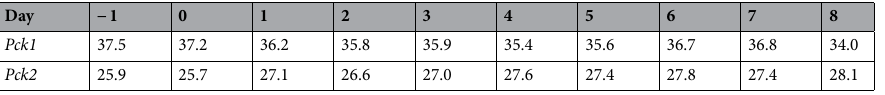
Table 1. Average Crossing Point (Cp) values for murine Pck1 and Pck2 mRNA expression in C2C12 cells during myogenic